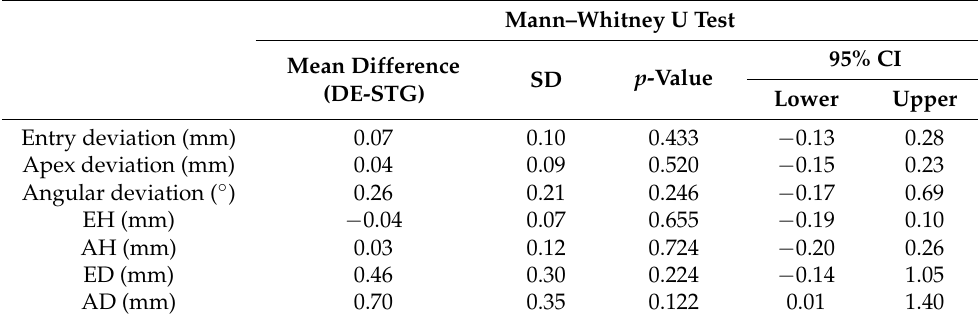
Table 3. Difference of implant position deviations between implants placed in single-tooth gaps (STG) and free-end gaps (DE).